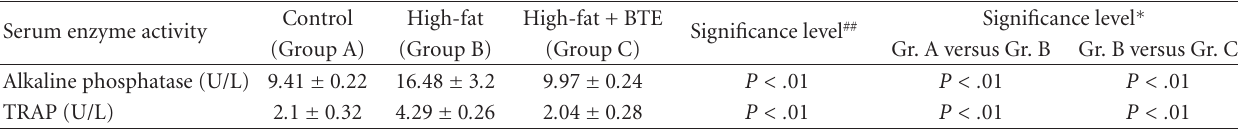
Table 2: Serum alkaline phosphatase (AP) activity and serum tartrate-resistant acid phosphatase (TRAP) activity in control (Group A), HFD (Group B) and HFD + BTE (Group C) supplemented groups of rats.